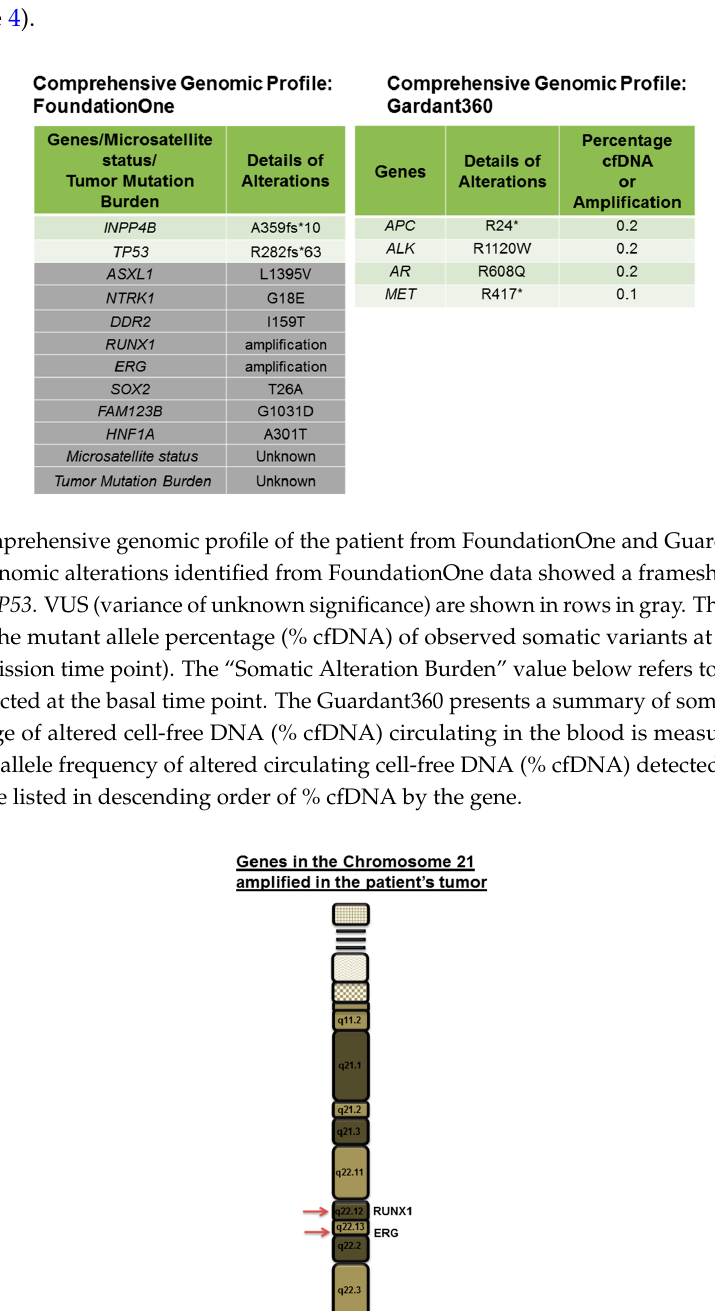
Figure 2. Bonafide cancer-related genes of chromosome 21 amplified in the patient’s tumor. VUS genes (Figure 1: in gray shade) from the FoundationOne results show that RUNX1 and ERG genes are amplified in the patient’s tumor.